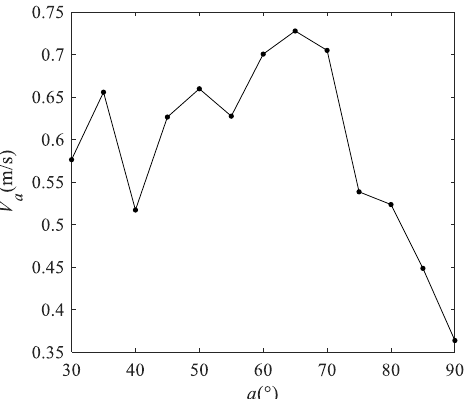
Figure 12. Relation between the vibration direction angle and particle average speed at A = 4 mm, f = 16 Hz, θ = 10°, and f c = 0.5.